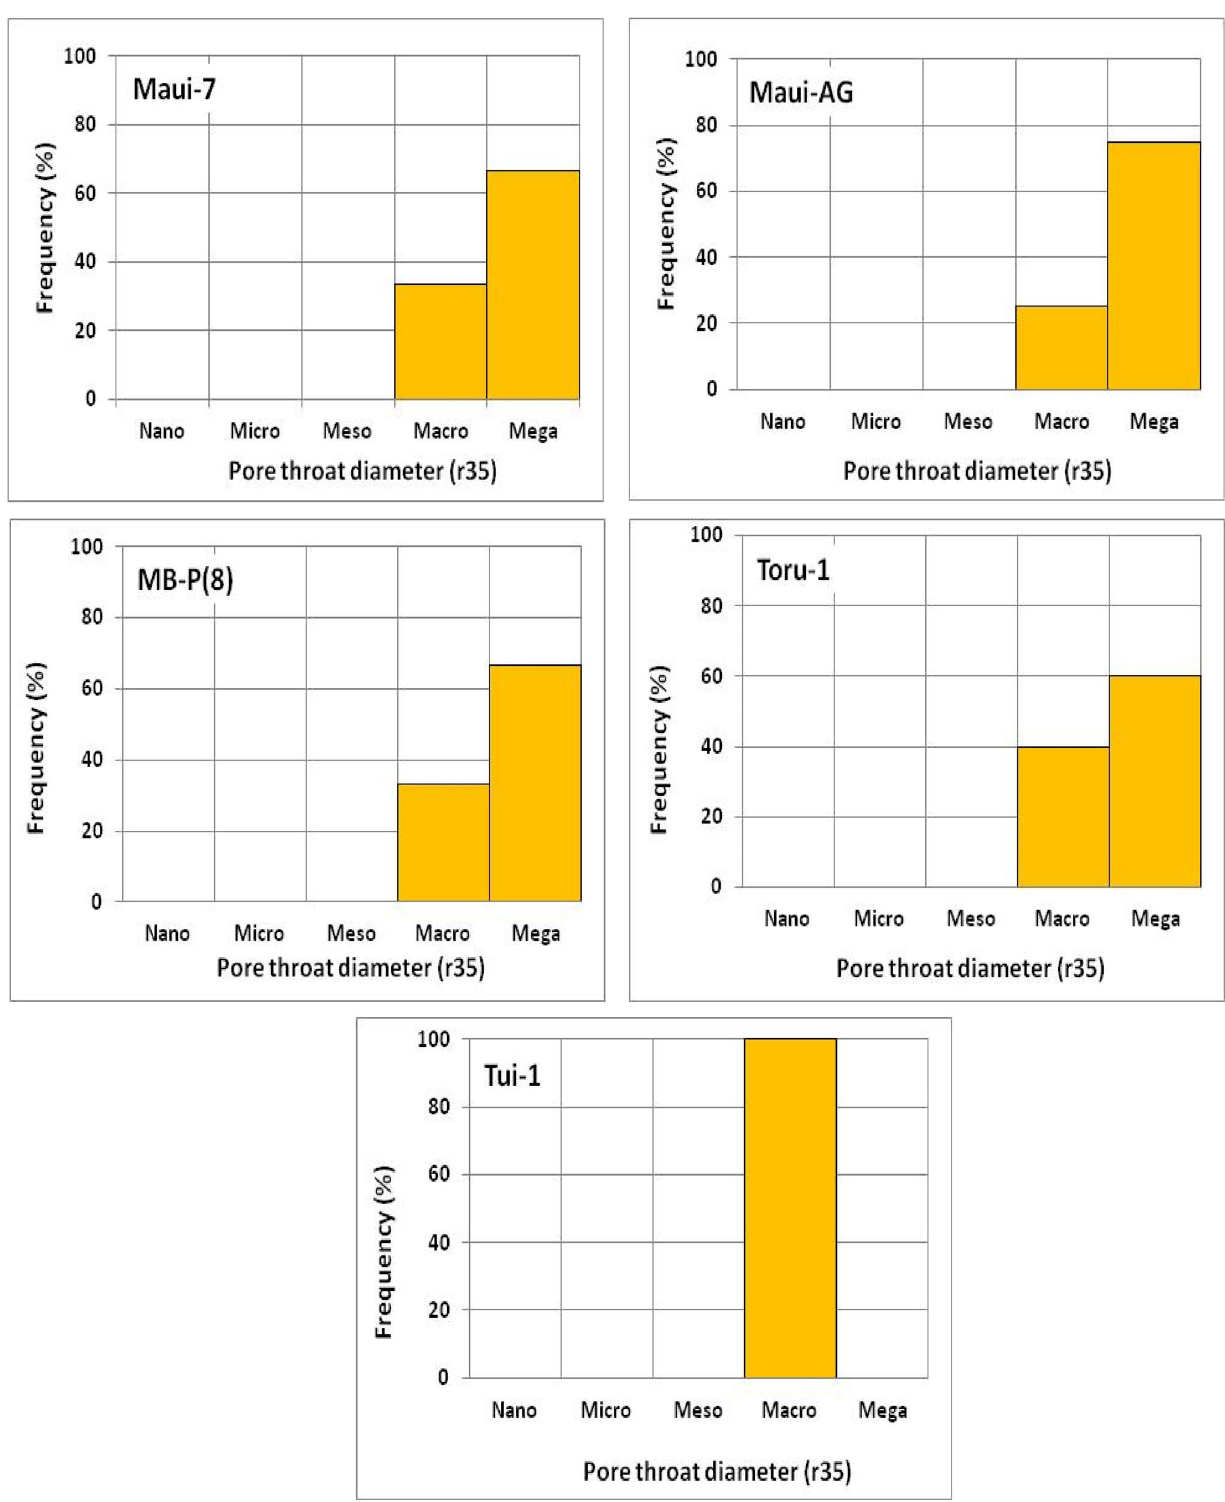
Fig. 13 Pore throat diameter and pore-type identification in the studied wells from r35